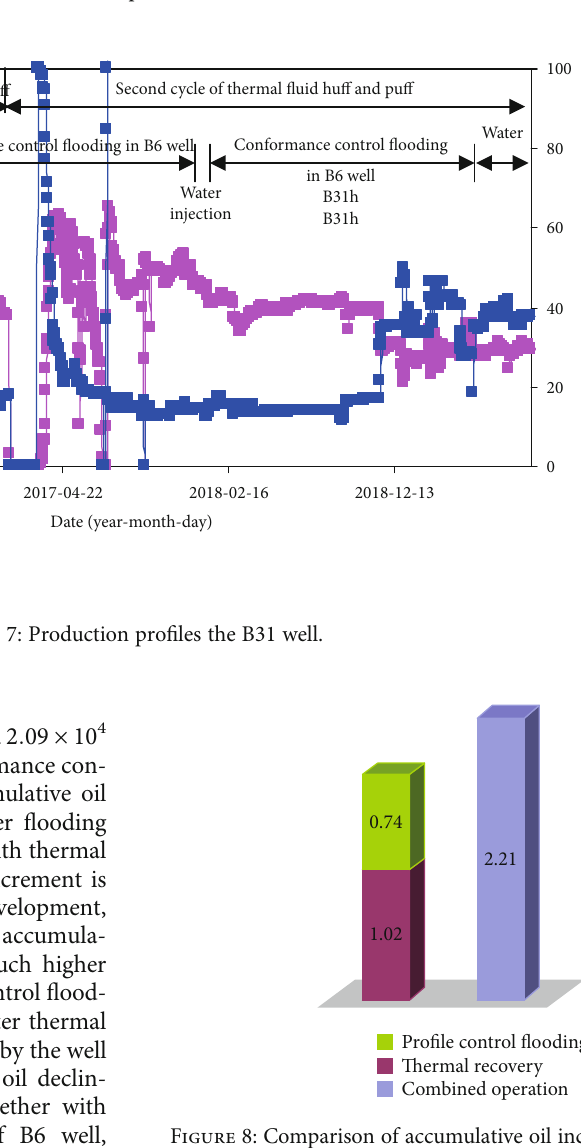
Figure 6: Production pro fi les of the B6 well.